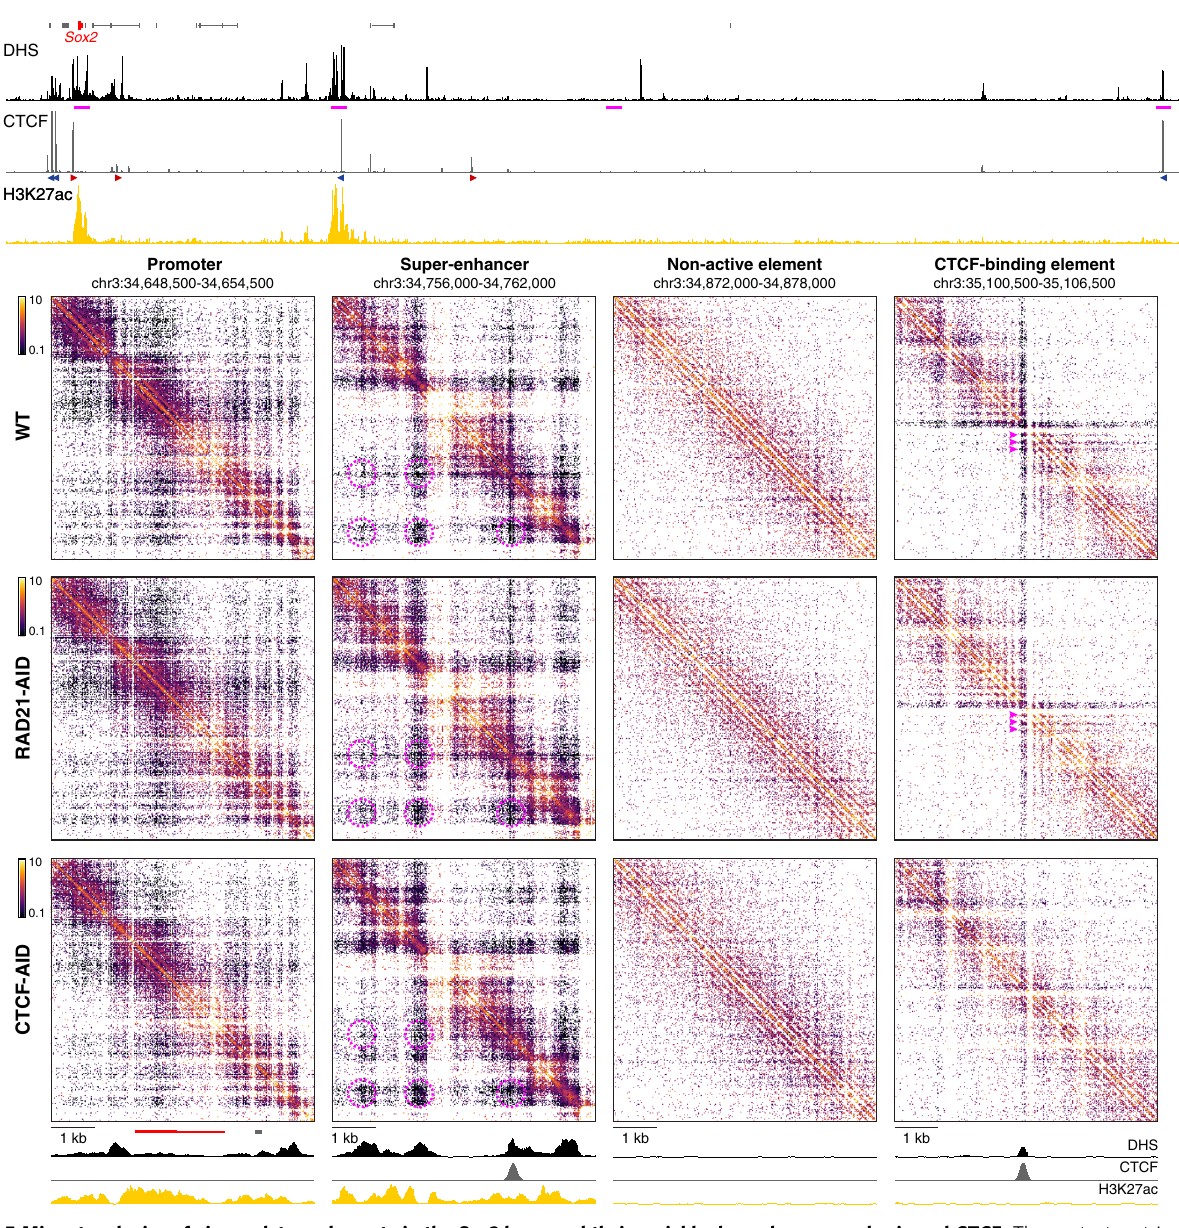
Fig. 5 Micro-topologies of cis -regulatory elements in the Sox2 locus and their variable dependence on cohesin and CTCF. The contact matrices show ligation junctions identi fi ed by Tiled-MCC in the Sox2 locus at 20 bp resolution in wild-type (WT), auxin-treated RAD21-AID, and auxin-treated CTCF-AID mES cells. Gene annotation ( Sox2 in red, coding genes in black, non-coding genes in gray), DNase hypersensitive sites (DHS), and ChIP-seq data for CTCF and H3K27ac for the extended Sox2 locus are shown above the matrices. The 6 kb regions covered in the contact matrices are highlighted with magenta bars below the top DHS pro fi le, and show a gene promoter, super-enhancer, non-active element, and CTCF-binding element. The axes of the top and bottom DHS and ChIP-seq pro fi les for CTCF and H3K27ac are fi xed and have the following ranges: DHS = 0 – 5; CTCF = 0 – 1500; H3K27ac = 0 – 50. The orientations of CTCF motifs at prominent CTCF-binding sites are indicated in the top panel by arrowheads (forward orientation in red; reverse orientation in blue). The magenta highlights in the contact matrices covering the super-enhancer indicate enriched interactions between DHSs; the magenta highlights in the contact matrices covering the CTCF-binding element indicate phased